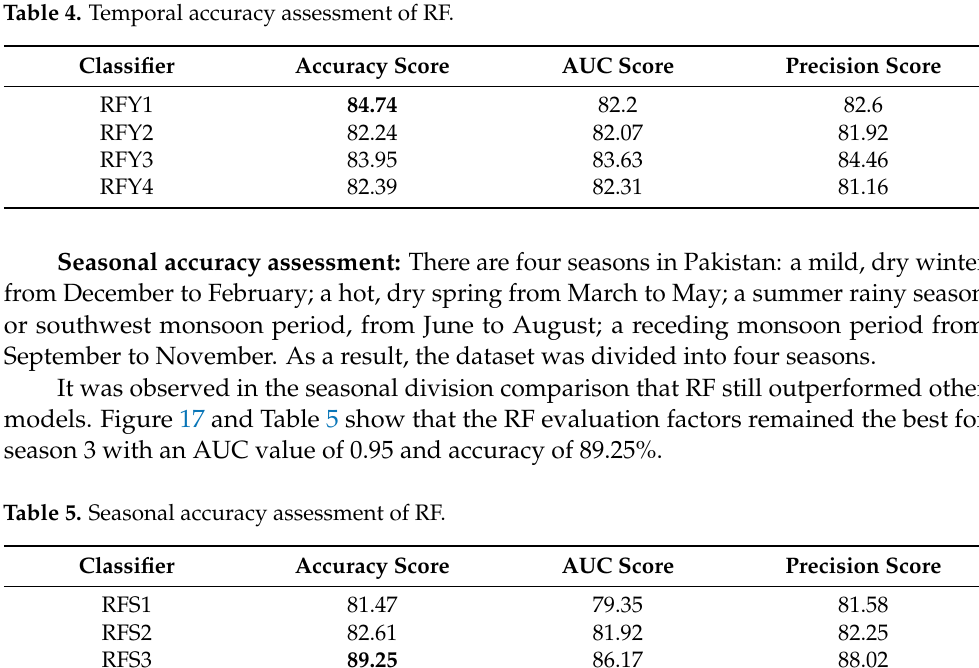
Figure 17. Random forest AUC variation in four different seasons.